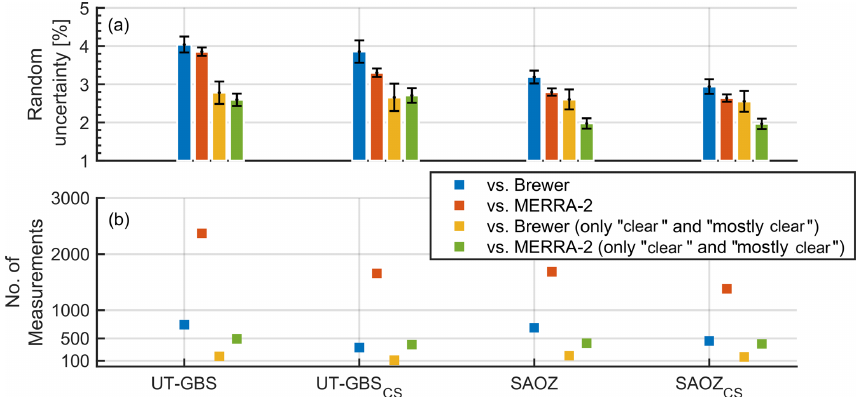
Figure 9. Statistical uncertainty estimation results. Panel (a) shows the estimated random uncertainties (%) and panel (b) shows the number of coincident measurements used. The x axis indicates names of TCO datasets that have been assessed. Colours represents different reference datasets (shown in